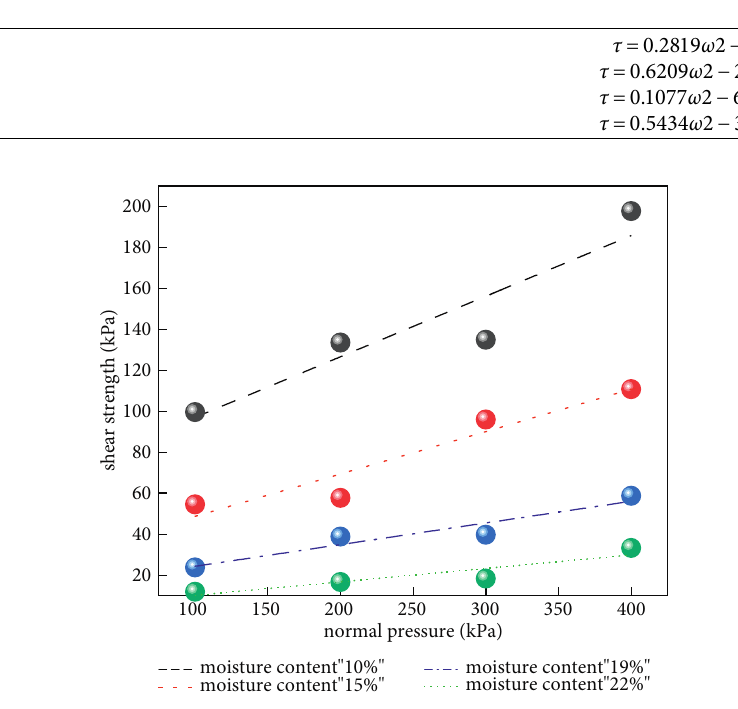
Figure 7: Relationship between moisture content and shear strength of silty